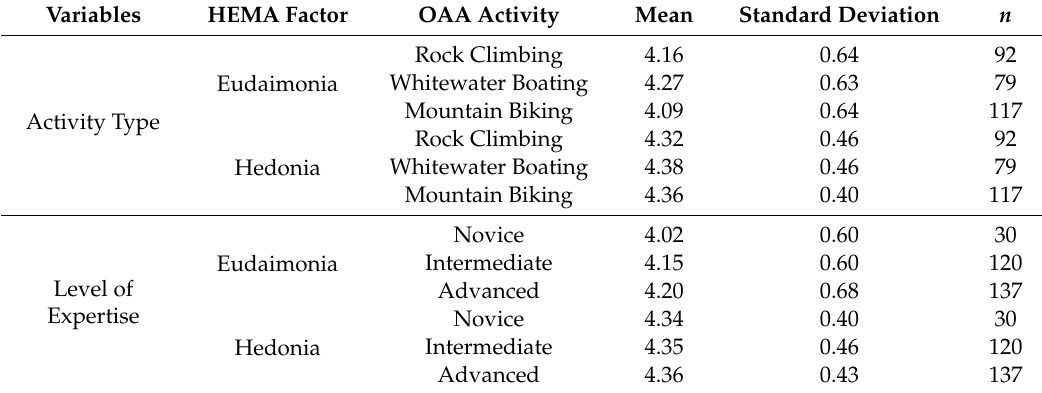
Table 2. Descriptive statistics mean